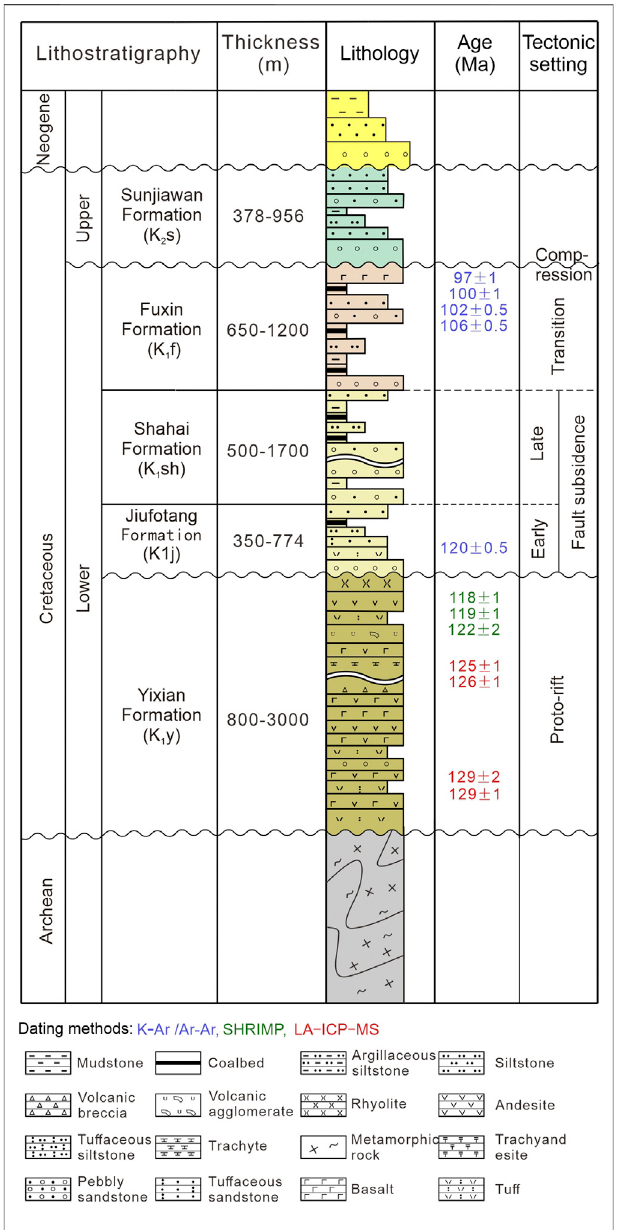
FIGURE4| Columnarsection oftheFuxinBasin(modi fi edafter Suet al., 2020; Jia et al., 2021).